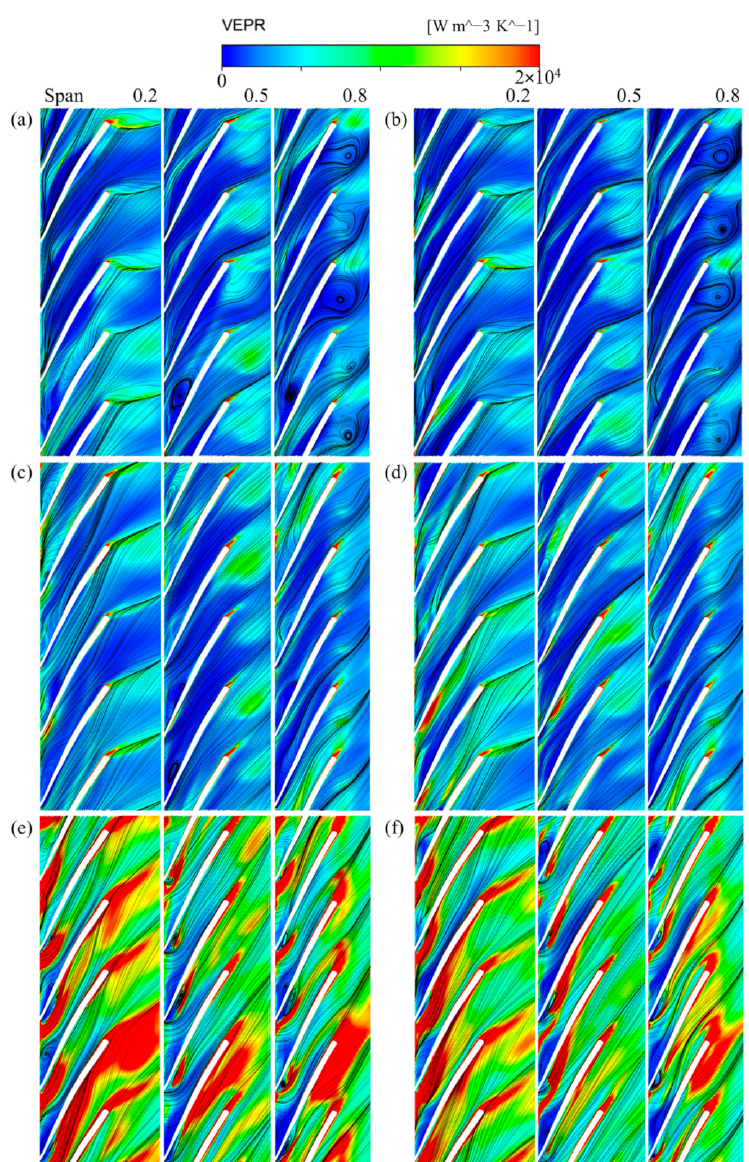
Figure 13. VEPR and streamlines distributions at the different span‑wise surfaces of impeller1 and impeller5 with different various flow rate conditions: ( a ) impeller1 in 0.73 Q d , ( b ) impeller5 in 0.73 Q d , ( c ) impeller1 in 1.0 Q d , ( d ) impeller5 in 1.0 Q d , ( e ) impeller1 in 1.45 Q d , ( f ) impeller5 in 1.45 Q d